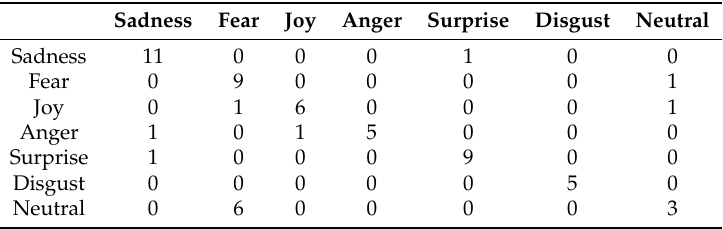
Table A24. A7 actor confusion matrix from the Emo-DB in the third